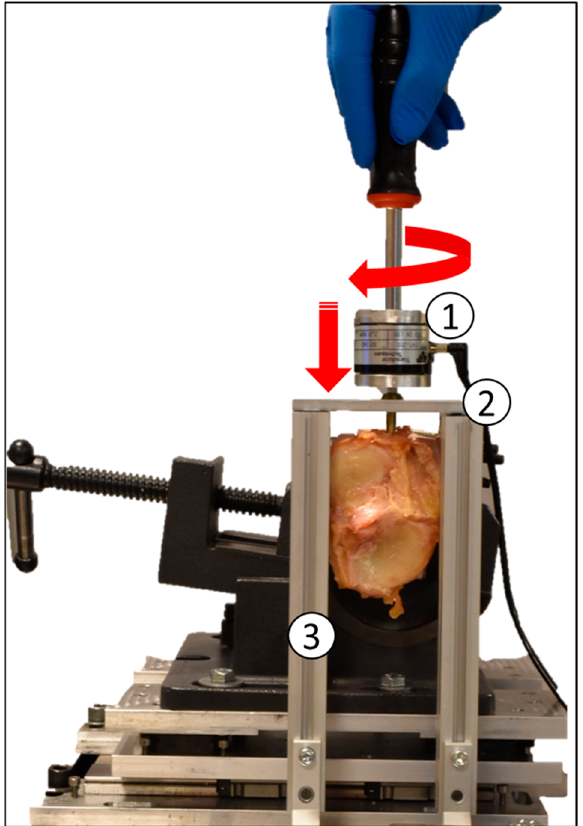
Figure 2. Experimental setup used for the screws insertions that includes a torque meter sensor